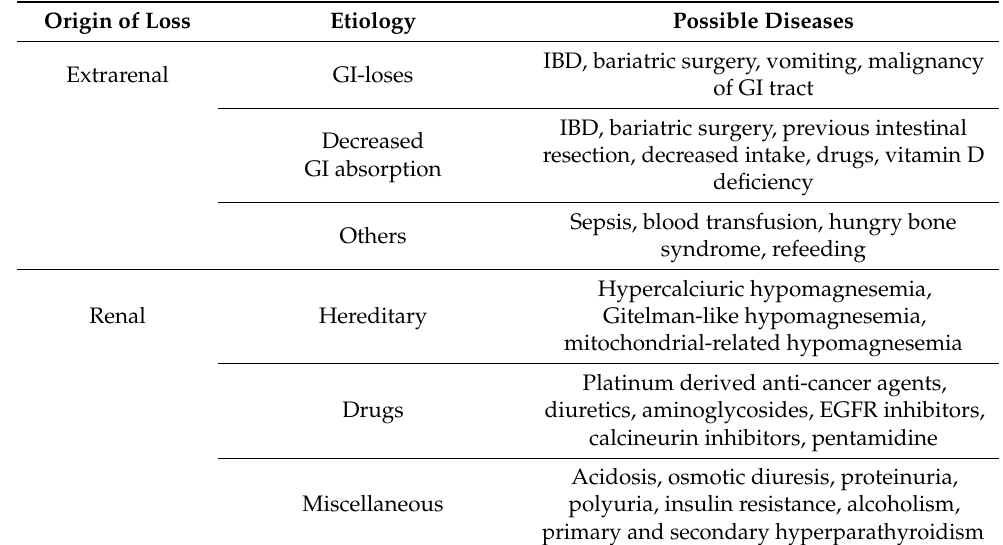
Table 4. The causes of hypomagnesemia. Hypomagnesemia may result from either reduced intake and bioavailability or increased renal and gastrointestinal